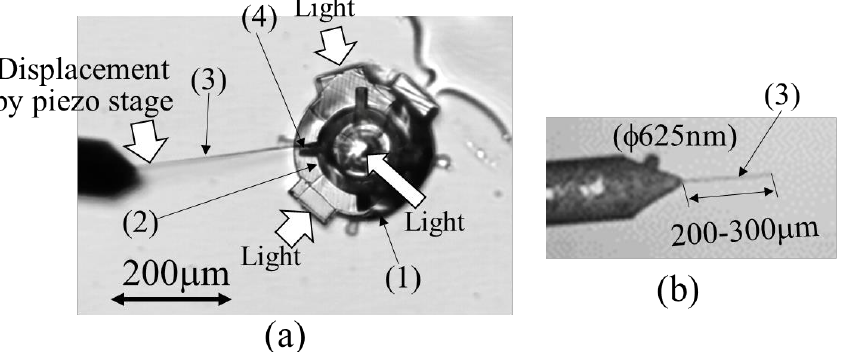
Figure 5. Torque-sensing system: (1) Experimental apparatus, (2) Rotating ring, (3) Micro-torque wrench, (4) Hand, ( a ) Torque-sensing using micro-torque wrench, ( b ) Micro-torque wrench. In the experiment, the micro-torque wrenches were broken several times; thus, we used microcantilevers with a length in the range of 185.6–237.8 µ m to determine the contact point of the micro-torque wrench with the device. The length was measured by counting tip of the micro-torque wrench and the projection of the rotating ring. In the experiment, a green laser (wavelength = 532 nm, output power = 5 W) with a wavelength that is relatively